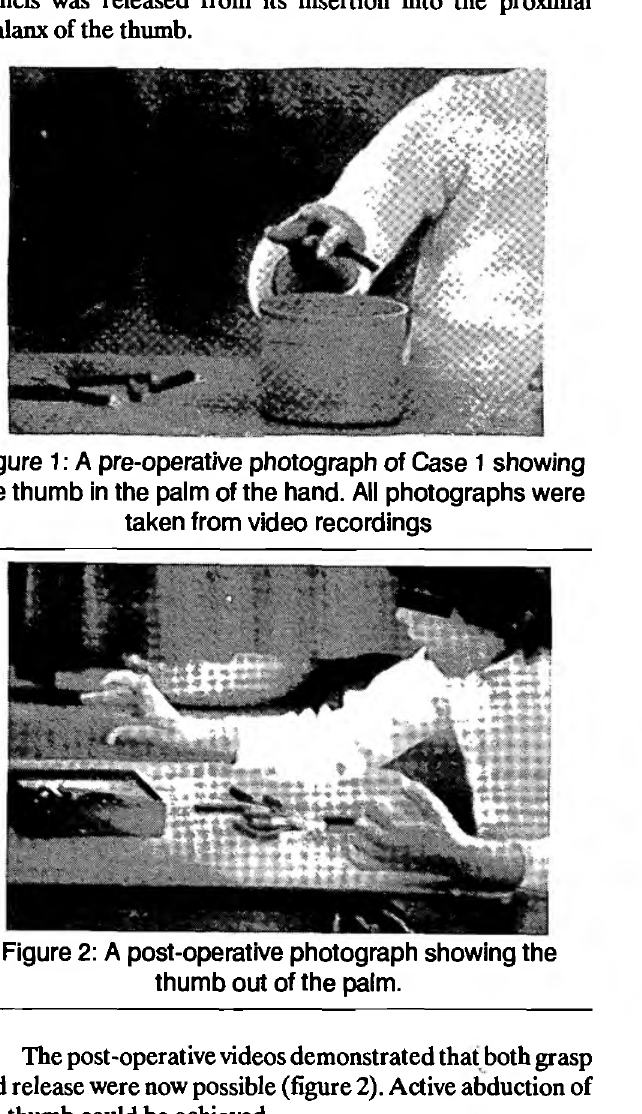
Figure 2: A post-operative photograph showing the thumb out of the palm.